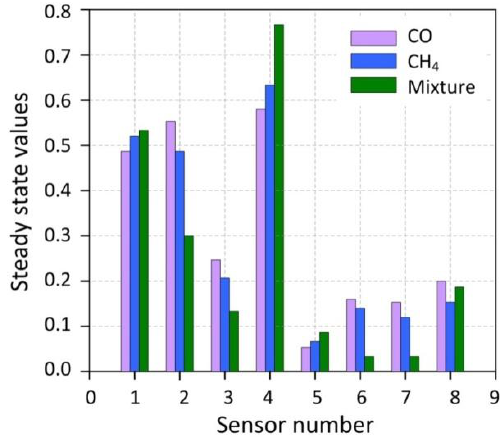
Figure 6. Histograms showing the response patterns of the eight gas sensors exposed to CO, CH , and their 4